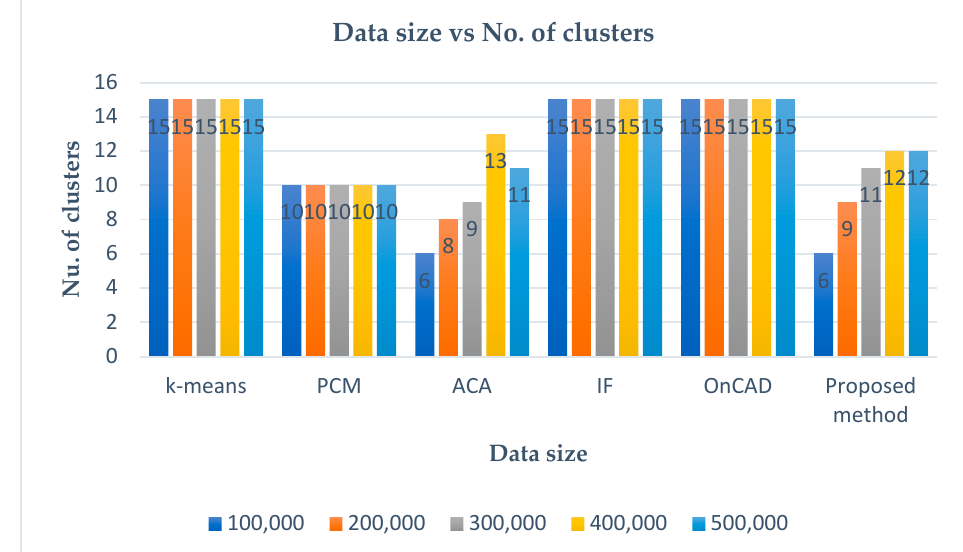
Figure 3. Comparative analysis of output clusters using Kitsune. Table 6. Comparative analysis of anomalies using KDDCUP’99.